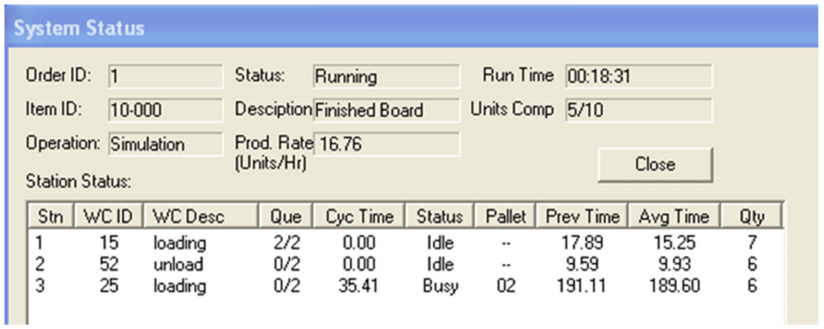
Figure 7. System status